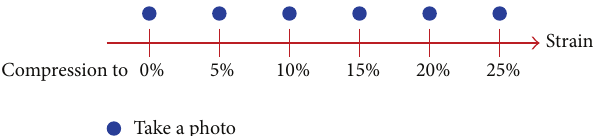
Figure 4: Strain intervals while applying load for taking photos to measure displacement of the prepared